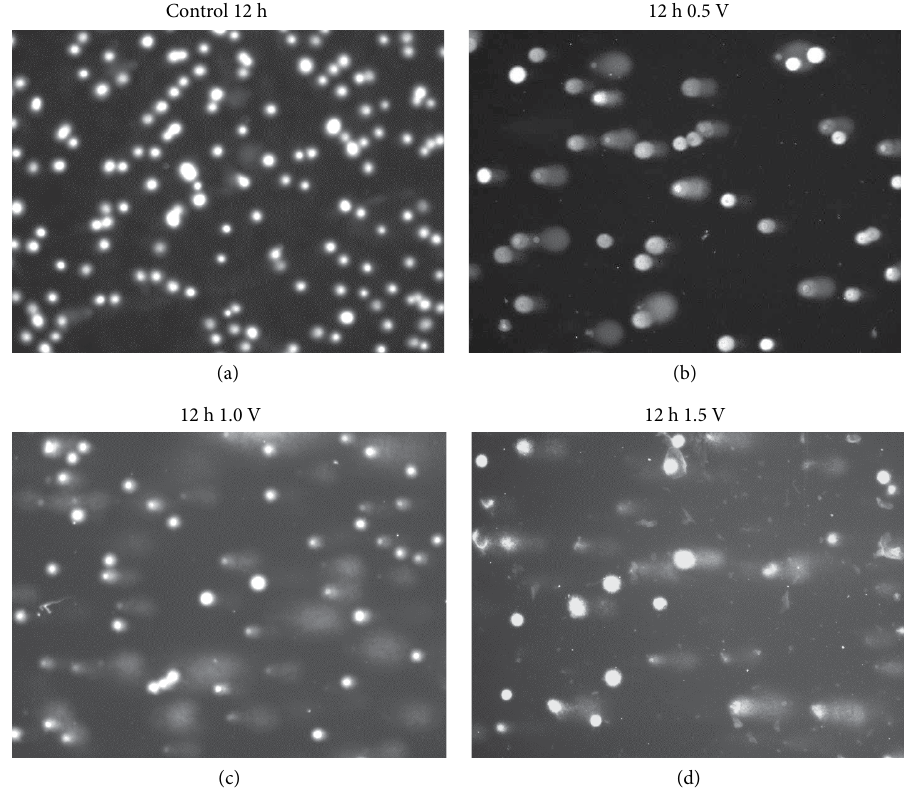
Figure 3: Fluorescent microscope images of representative comets (a) control, open circuit for 12 h (b) treated for 12 h at 퐸 = 0.5 V (c) treated for 12 h at 퐸 = 1.0 V (d) treated for 12 h at 퐸 = 1.5 V. The comet tails indicate the extent of DNA strand